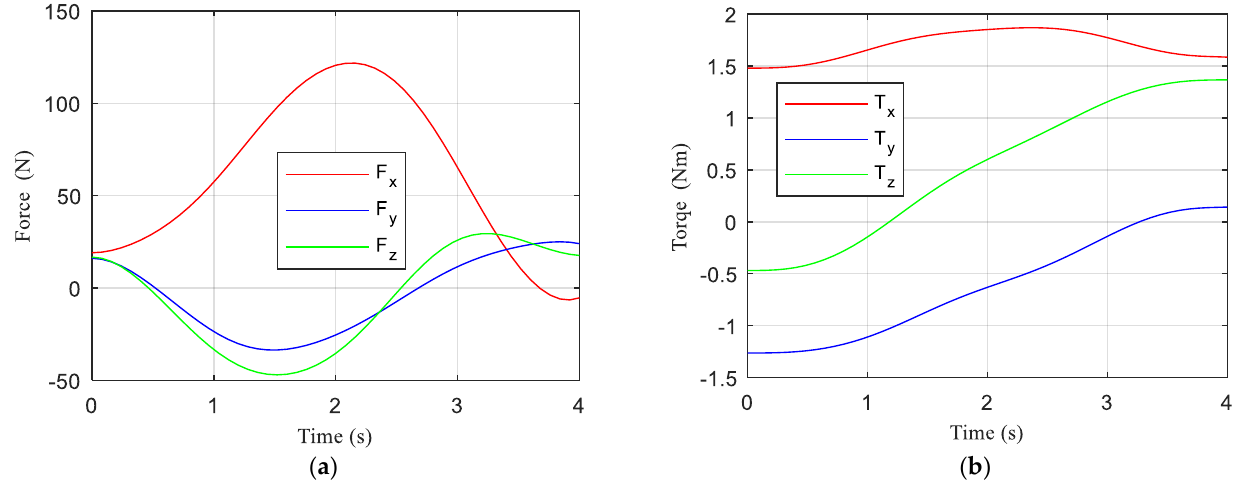
Figure 9. The real-time force/torque on the end effector of the humanoid manipulator. ( a ) Real-time force on the end effector; ( b ) Real-time torque on the end effector.